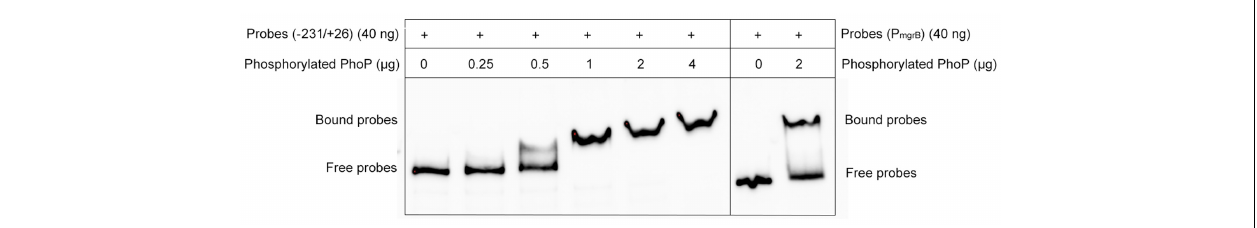
FIGURE 2 | Electrophoretic mobility shift assays (EMSAs) of PhoP to the folA promoter region. A varying concentration of the PhoP (0, 0.25, 0.5, 1, 2, and 4 µ g) was incubated with PCR-amplified biotin-labeled probes of the promoter regions of folA , and the binding of PhoP (2 µ g) to the promoter regions of mgrB was used as the positive control, showing that PhoP recognized and bound to the promoter of folA . The experiment was repeated at least three times and a representative result was presented.